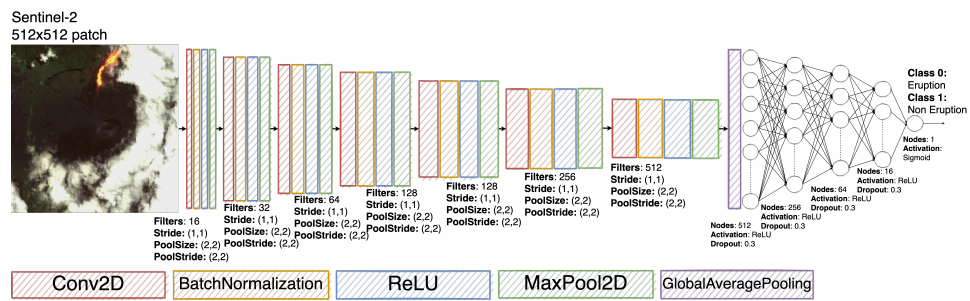
Figure 4. Network